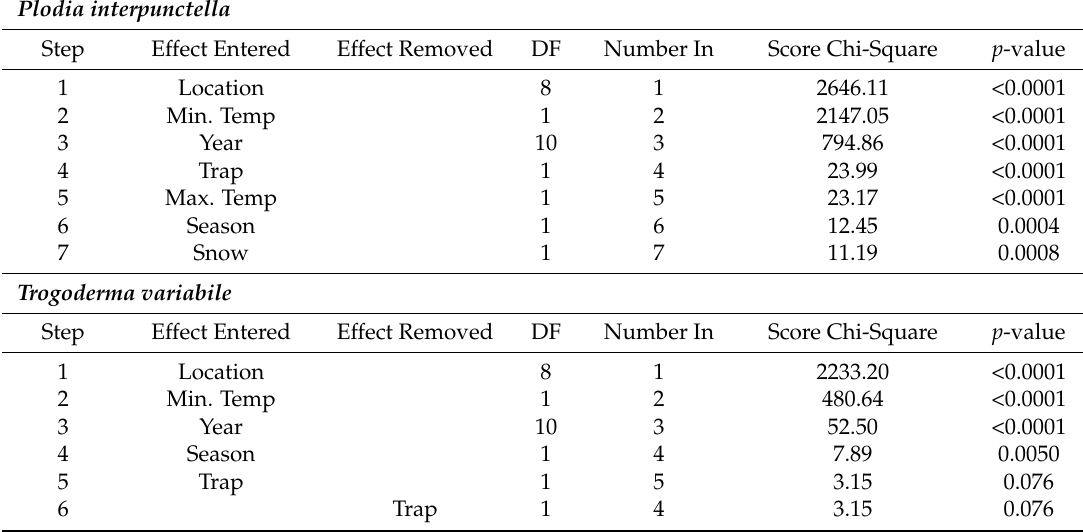
Table 1. Stepwise proc phreg model building of environmental, location, and timing variables for P. interpunctella and T. variabile . Possible variables entered are: season, year, location, trap, precipitation, maximum temperature, minimum temperature, and snow fall. Entry requirement p = 0.15; stay requirement p <